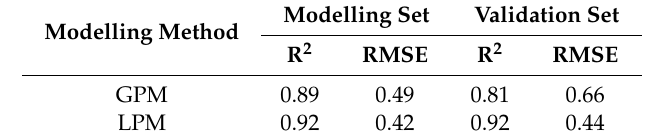
Table 7. Canopy volume parameter (CVP) prediction results according to the random forest (RF) methods.